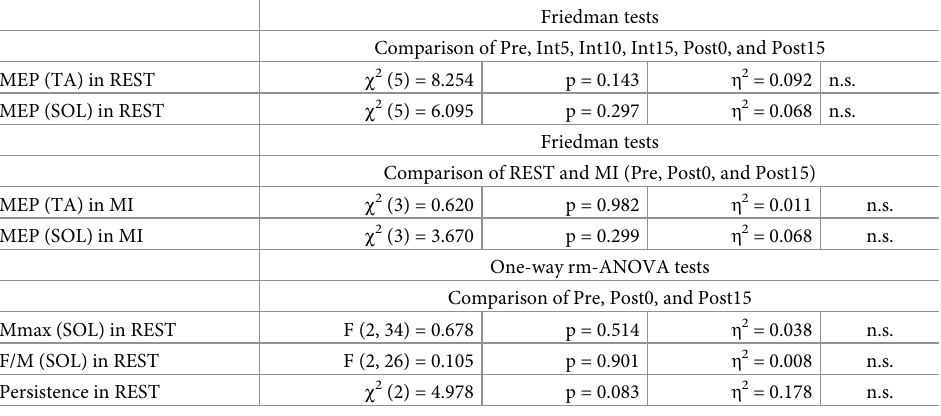
Table 4. Test statistic values, p-values, effect sizes of Friedmann tests and one-way rm-ANOVA tests for the nor- malized MEP (% of Pre), non-normalized Mmax, F/M, and persistence of